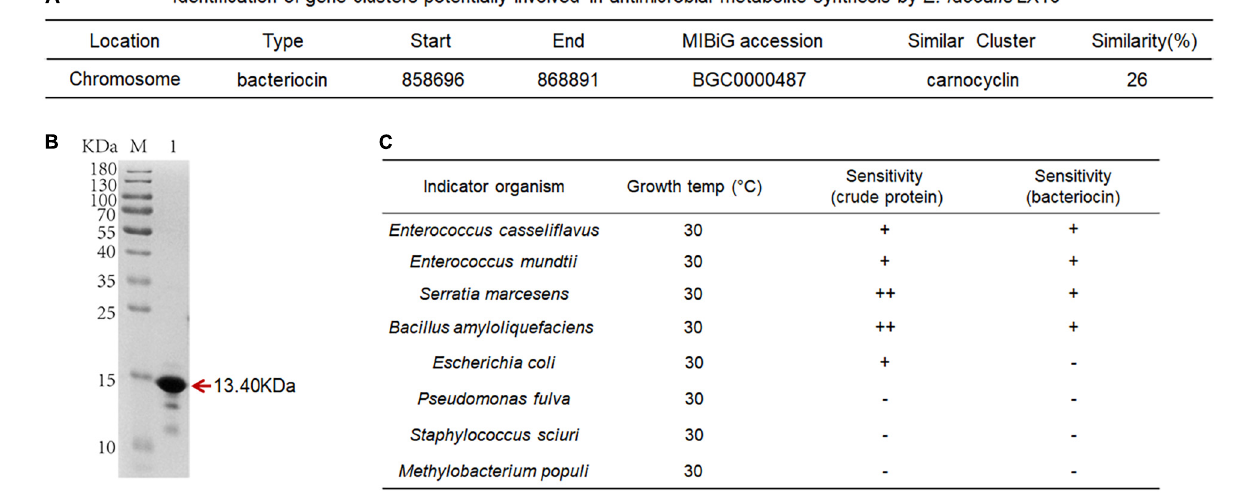
FIGURE 6 | Characterization of bacteriocin and inhibitory activity. (A) Identification of gene clusters potentially involved in antimicrobial metabolite synthesis by E. faecalis LX10. (B) SDS–PAGE gel showing the reconstitution and purification of bacteriocin proteins. (C) Inhibition spectrum of the crude protein (2 mg/mL, 100 µ L) from the cell-free culture supernatant and bacteriocin (2 mg/mL, 100 µ L) produced by E. faeca lis LX10. E. casseliflavus LX10, E. mundtii LX11, S. marcescens LX12, B. amyloliquefaciens , E. coli , P. fulva , S. sciuri , and M. populi as the indicator. –, no inhibition; + , inhibition; ++ good